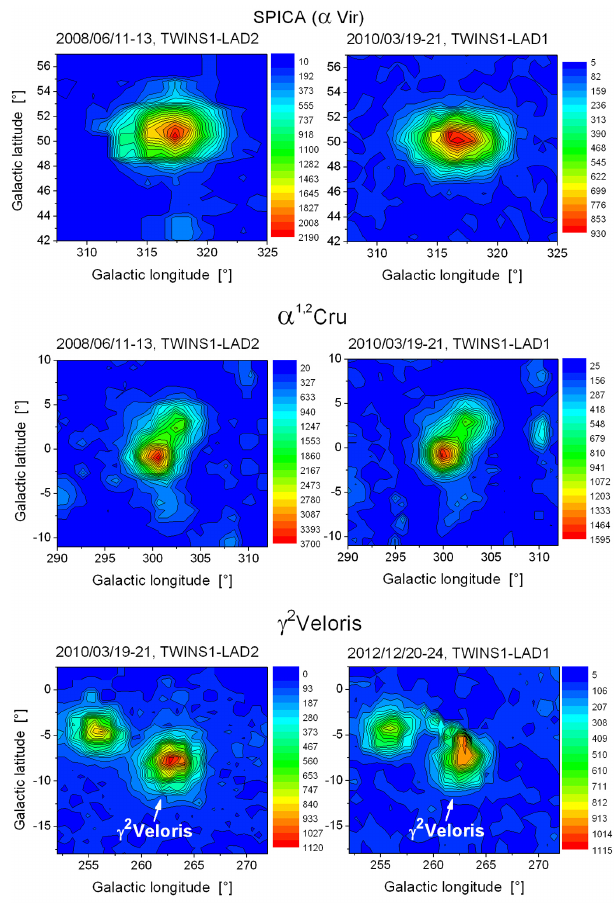
Figure 5. TWINS 1 LAD observations of stellar UV emission in [counts/0.67s] from UV-bright stars (separated from exospheric and interplanetary emission): Spica ( α Vir) in 2008 and 2010 (top), α 1 , 2 Cru in 2008 and 2010 (middle), and γ 2 Vel in 2010 and 2012 (bottom).